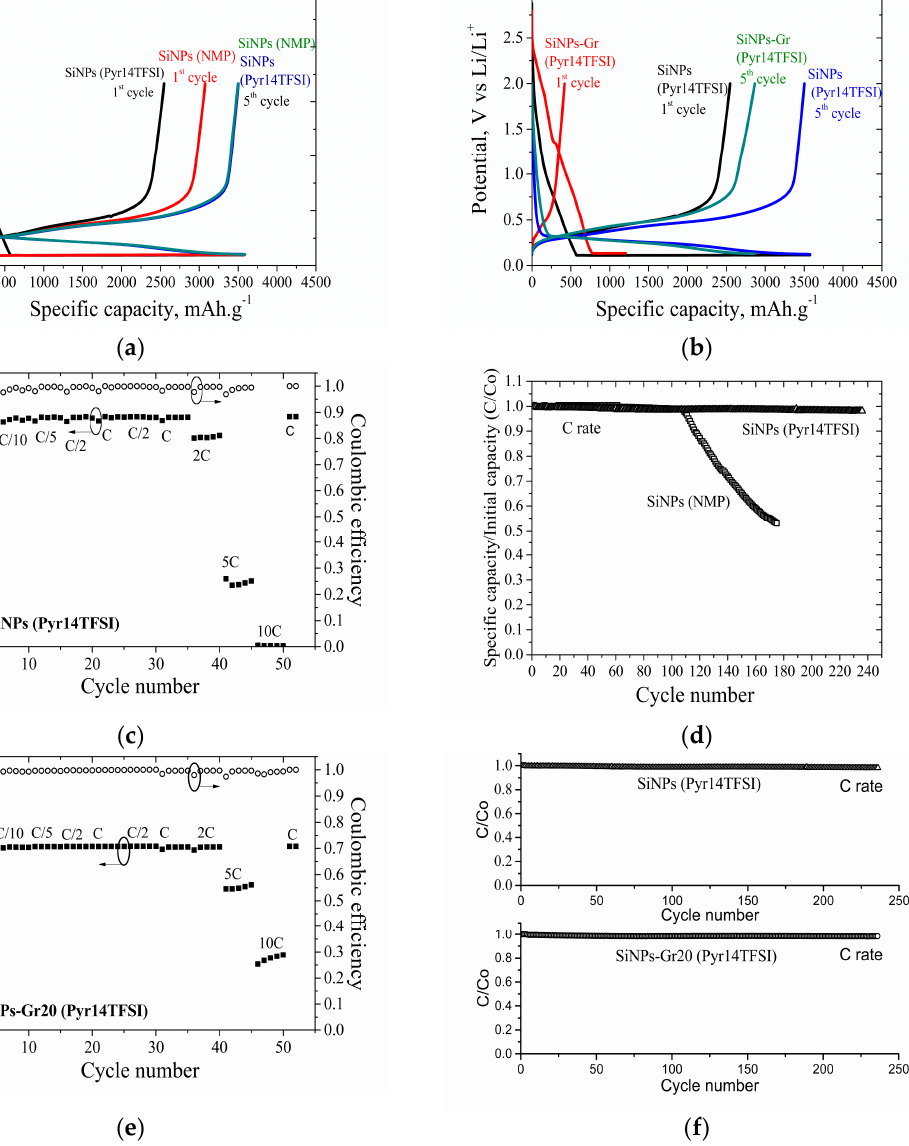
Figure 7. Two-dimensional SiNPs (Pyr14TFSI) electrode (mass of 26 µg·cm − 2 ): ( a ) Voltage versus capacity curves at C/20 rate with SiNPs (NMP) and ( b ) with SiNPs-Gr20 (Pyr14TFSI) electrode (mass of 10 µg·cm − 2 ); ( c ) Galvanostatic profile of specific capacities (square dot) and coulombic efficiency (circle dot) at different densities; ( e ) the same for SiNPs-Gr20 (Pyr14TFSI); ( d ) Galvanostatic profile of specific capacities divided by the initial capacity at 1 C rate with SiNPs (NMP) electrode and ( f ) with SiNPs-Gr20 (Pyr14TFSI) electrode.